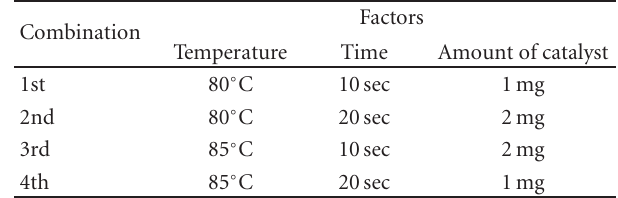
Table 1: An experiment design problem with three factors and two levels per factor.